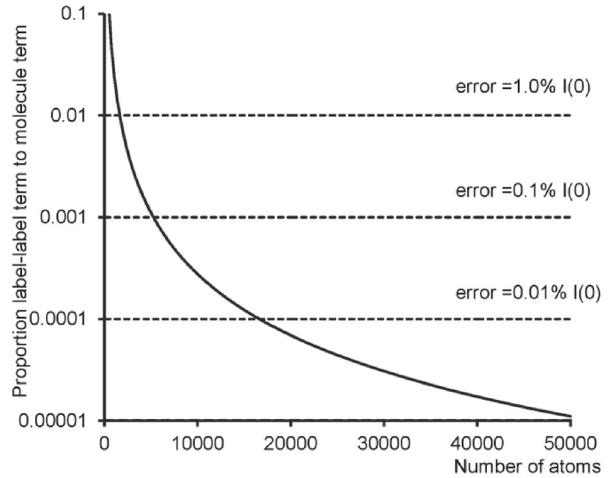
Figure 7. The ratio of the difference in the scattered label-label contribution to the molecular scattering intensity as a function of the number of atoms in the molecule (solid line), for gold nanocrystal labels. Also shown are the errors at selected levels (dashed lines). Intersection of the error line with the solid curve shows the maximum number of atoms in the molecule which can be used for that error level.